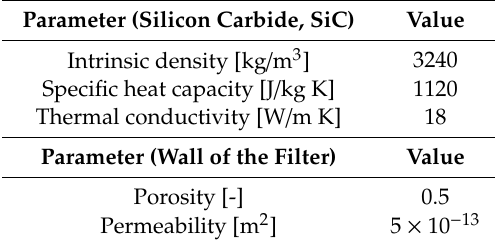
Table 3. Properties of the support material (Silicon Carbide, SiC), and porosity and permeability of the (clean) wall of the